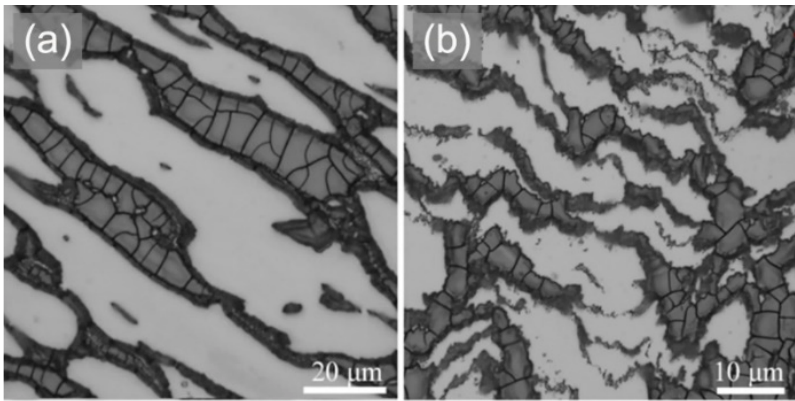
Figure 2. Micromorphology of the ferrite and austenite phase boundaries ( a ) in the central region of the disk and ( b ) 2500 µ m from the center.